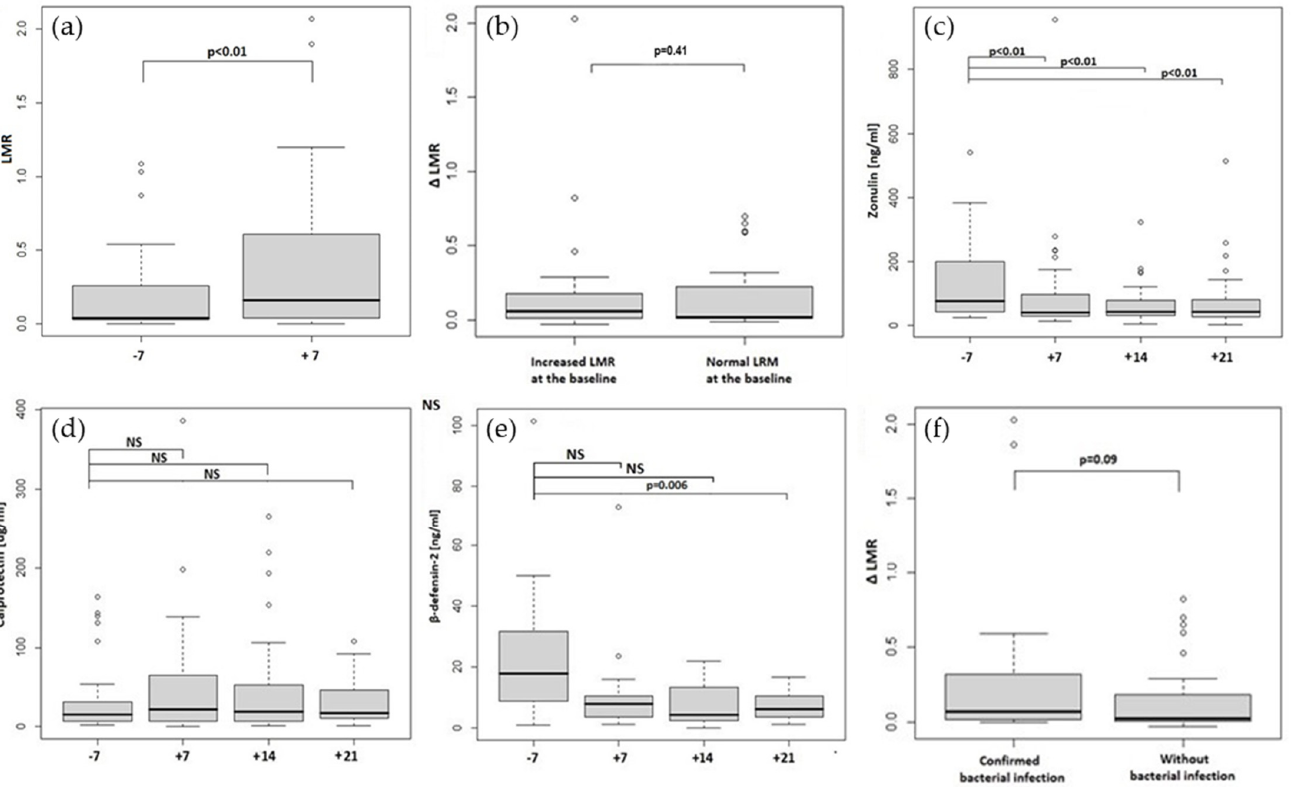
Figure 2. ( a ) increased intestinal permeability before and after the allo-HCT expressed as lactulose to mannitol ratio in the urine after the SAT test for the whole group; ( b ) change in intestinal permeability ( Δ LMR) in patients with already increased LMR at the baseline and patients with LMR at the baseline within the reference limit; ( c ) zonulin stool concentrations before the conditioning and in the post-transplant period; ( d ) calprotectin stool concentrations before the conditioning and in the post-transplant period; ( e ) beta-defensin-2 stool concentrations before the conditioning and in the post-transplant period; ( f ) change in intestinal permeability ( Δ LMR) in patients with confirmed bacterial infection compared to those without this complication. A p -value less than 0.05 is considered to be statistically significant. Table 1. Associations between median intestinal permeability (LMR) on day − 7 before transplantation, day +7 after transplantations, and median difference between these values ( Δ LMR) and characteristics of patients and transplantation. A p -value less than 0.05 is considered to be statistically significant. Patient